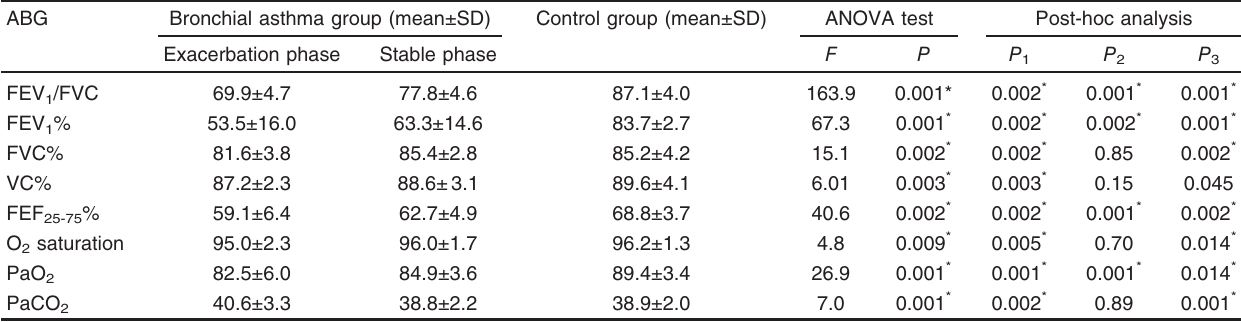
Table 1 Comparison of spirometric indices and arterial blood gases parameters during exacerbation phase, stable phase, and control group ABG Bronchial asthma group (mean±SD)